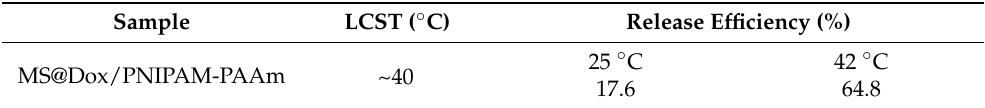
Table 1. Dox release efficiency from the MS@Dox/PNIPAm-PAAm system at different tempera- tures.